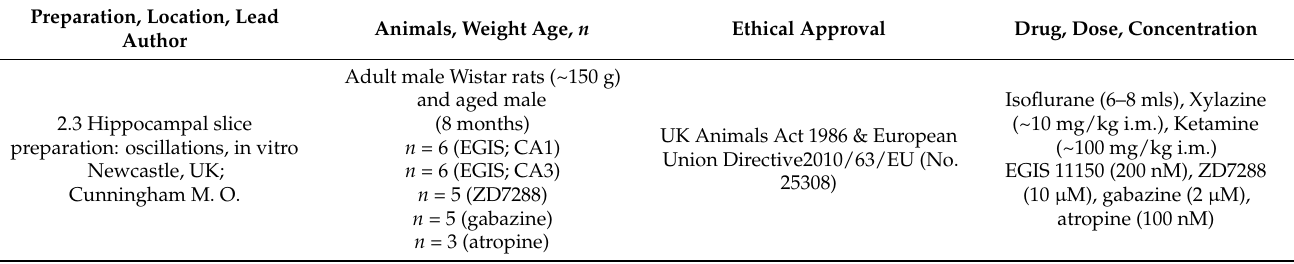
Table 1. Details of preparations, animals, and doses